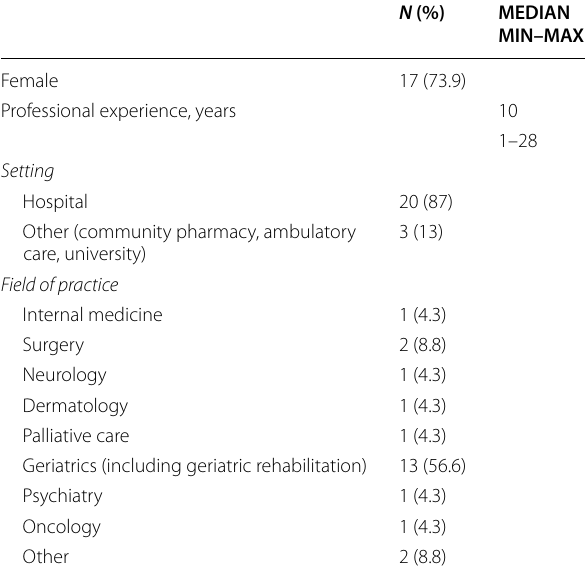
Table 2 Characteristics of healthcare professionals ( N